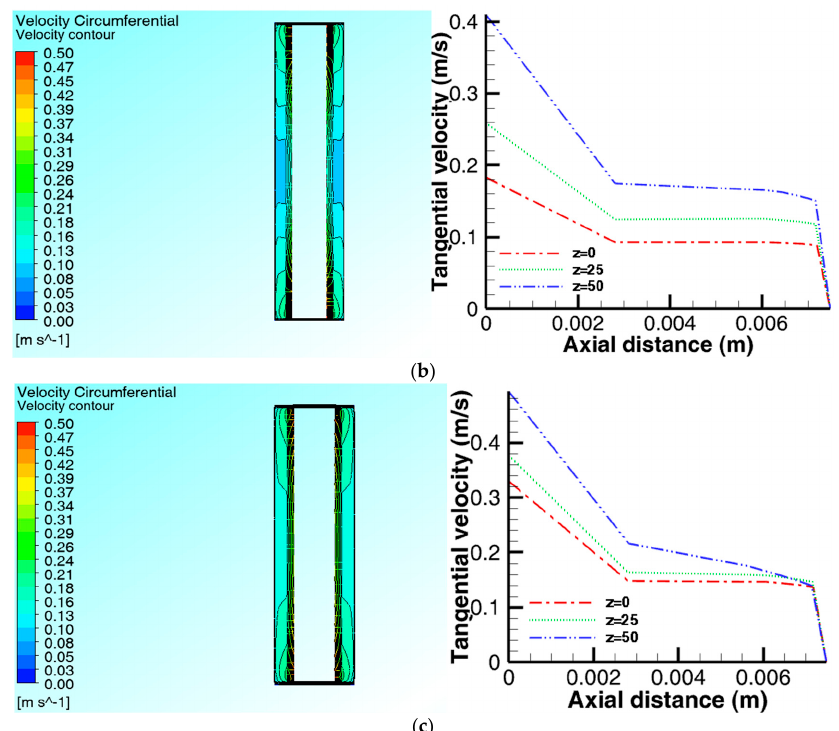
Figure 7. Reactor cross-sections showing the velocity contours and axial tangential velocity profiles along three horizontal lines in the X-Z plane at N = 70 rpm with the RNG model: ( a ) y = 0; ( b ) y = 0.025; ( c ) y = 0.045.